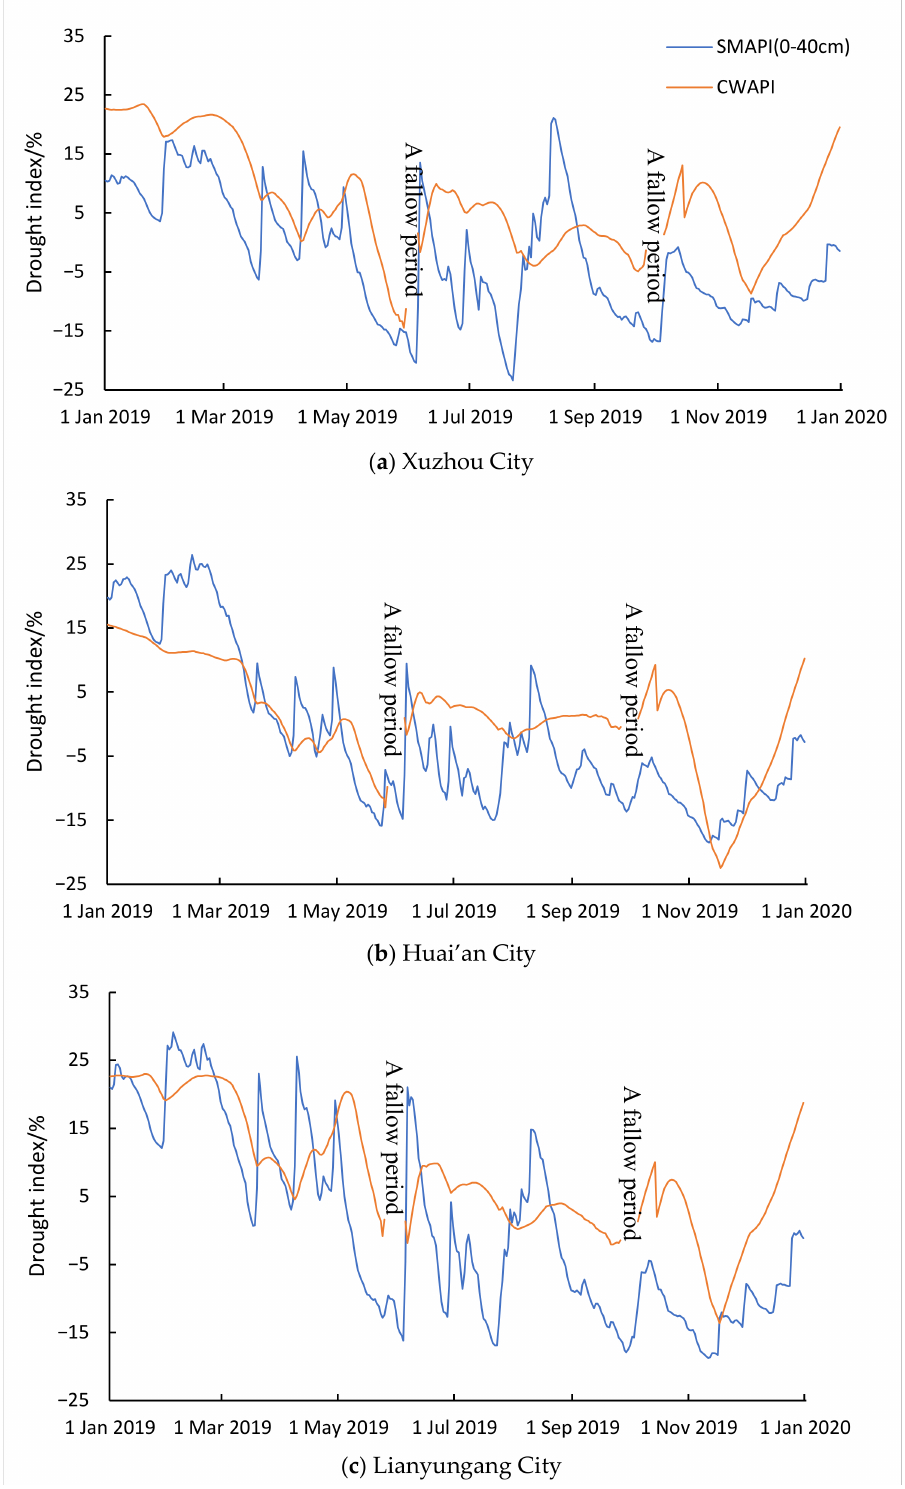
Figure 7. Time series of drought indices of Xuzhou ( a ), Huai’an ( b ), and Lianyungang ( c ) in